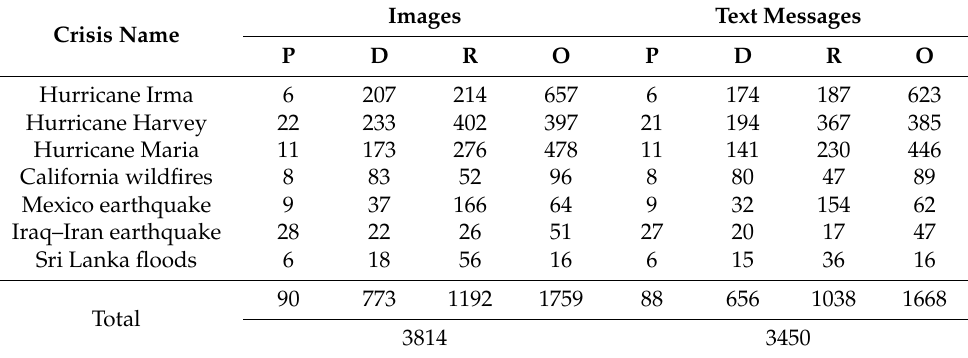
Table 3. The dataset division according to Task 2.